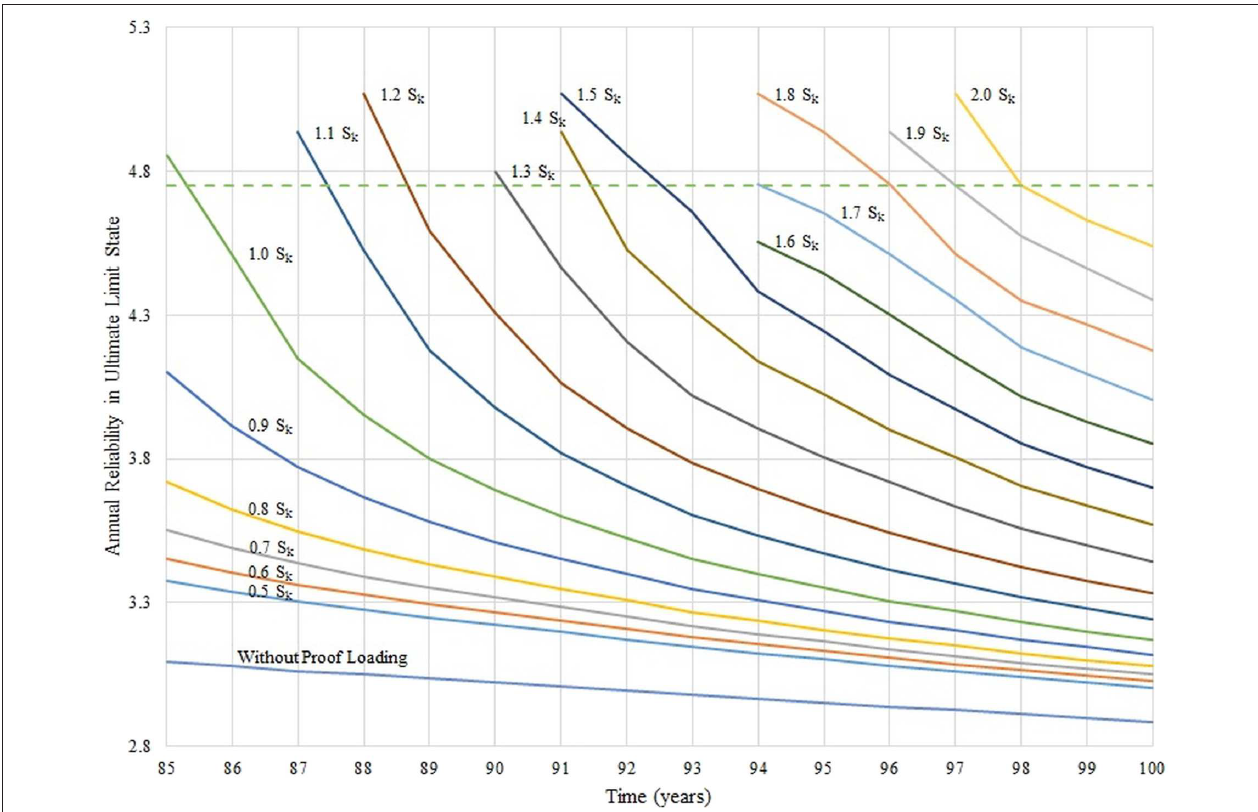
FIGURE 6 | Reliability level of the bridge during testing as a function of the proof load levels.